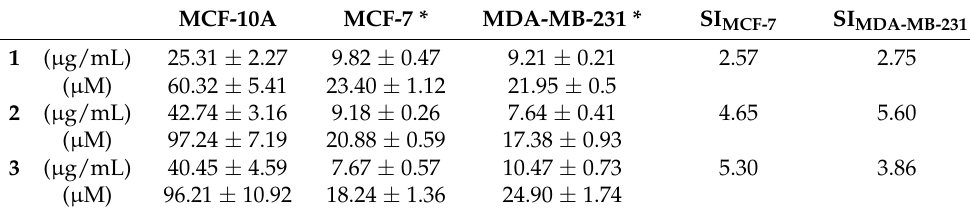
Table 1. Effect of compounds 1 – 3 , expressed as IC 50 values, on the viability of normal MCF-10A cells. MCF-10A MCF-7 * MDA-MB-231 * SI MCF-7 SI